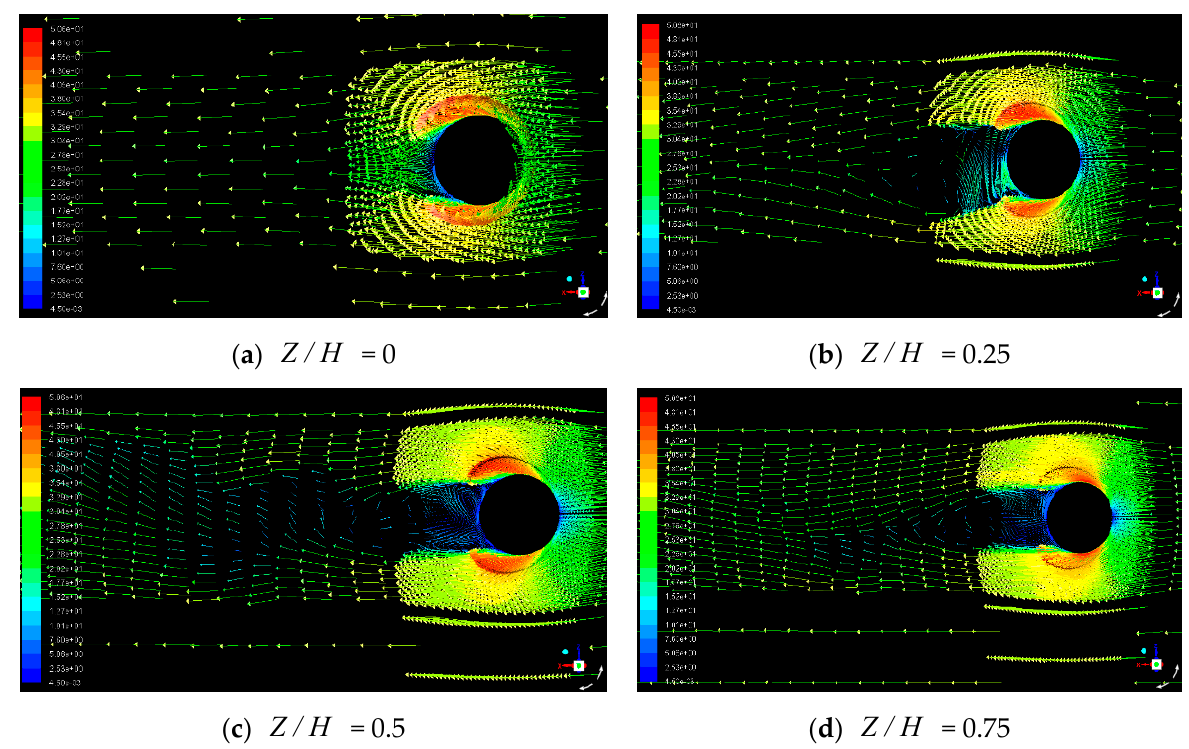
Figure 11. Instantaneous streamlines and contours of velocity in the horizontal plane at H / D = 0.3: ( a ) Z / H = 0; ( b ) Z / H = 0.25; ( c ) Z / H = 0.5 and ( d ) Z / H = 0.75.